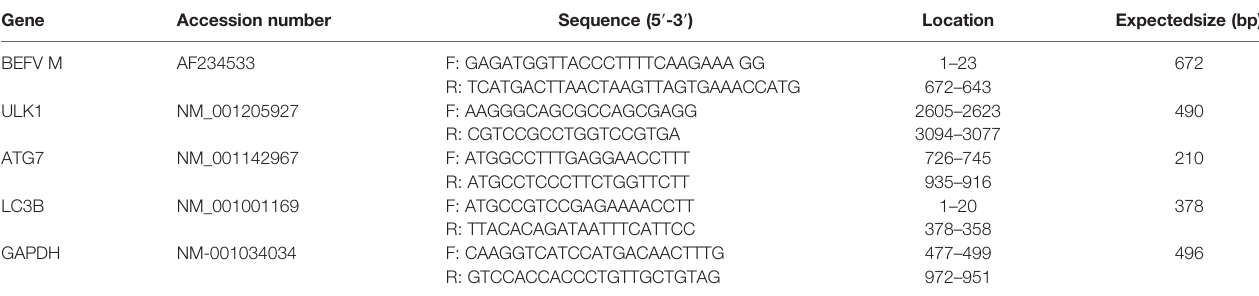
TABLE 2 | Primers used in this study for ampli fi cation of the respective targeted